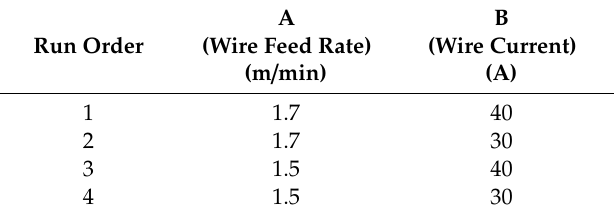
Table 5. Full factorial experimental design table.